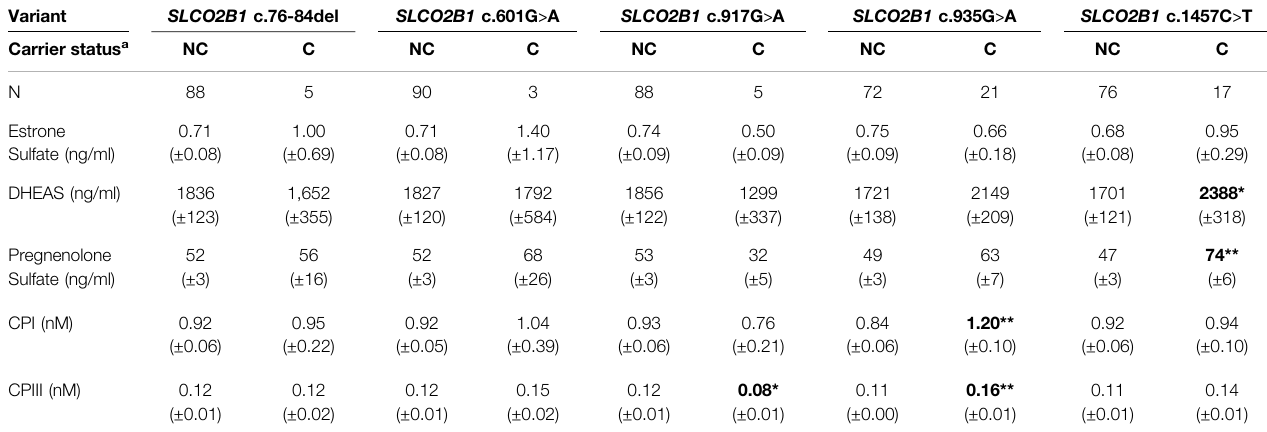
TABLE 4 | Univariate Analyses of SLCO2B1 gene variants with circulating endogenous substrate concentrations.